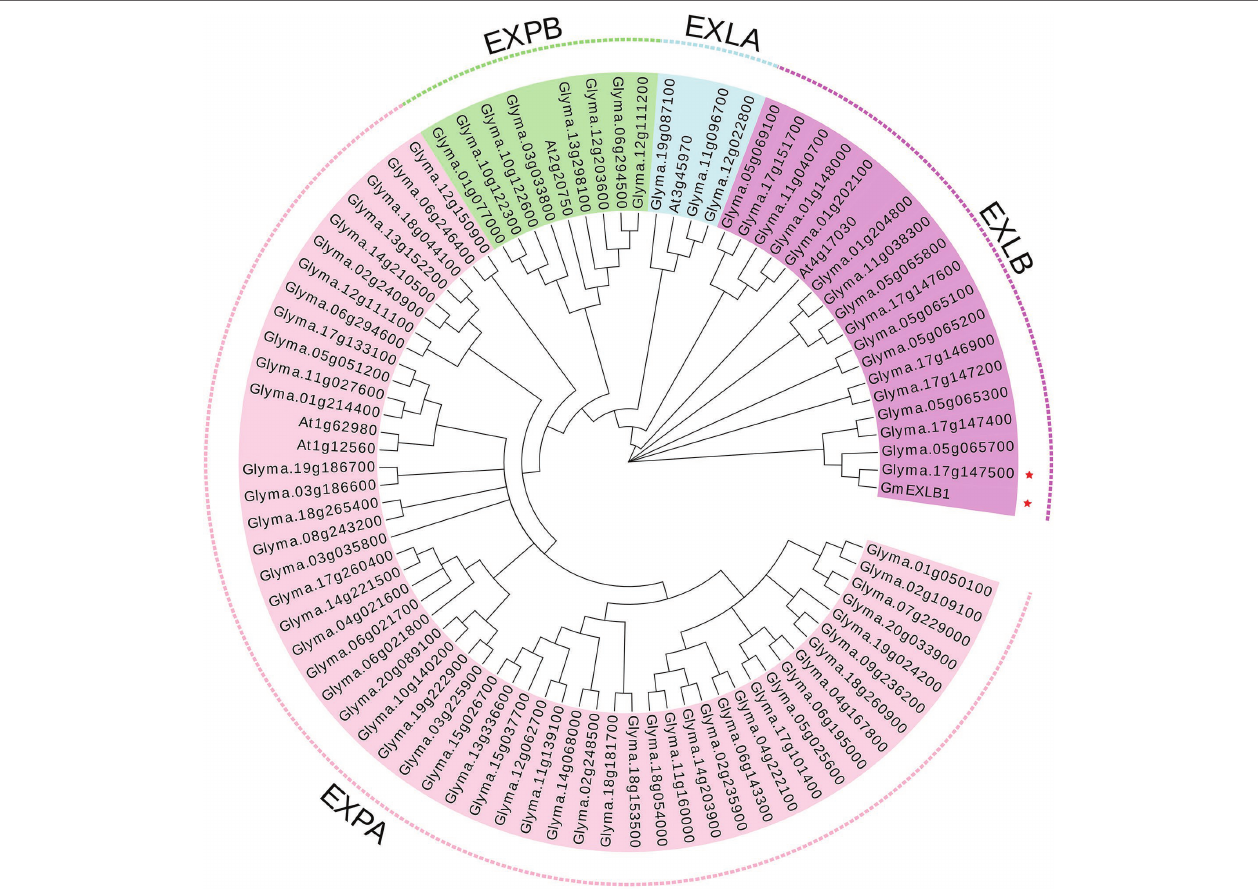
FIGURE 3 | Phylogenetic tree of expansins in soybean and Arabidopsis . Using expansins in soybean and Arabidopsis , a phylogenetic tree was constructed using the neighbor-joining method with 1,000 bootstraps in MEGA 7.0 and was modified by EvolView. The four expansin subfamilies are: EXPA, α -expansin; EXPB, β -expansin; EXLA, expansin-like A; and EXLB, expansin-like